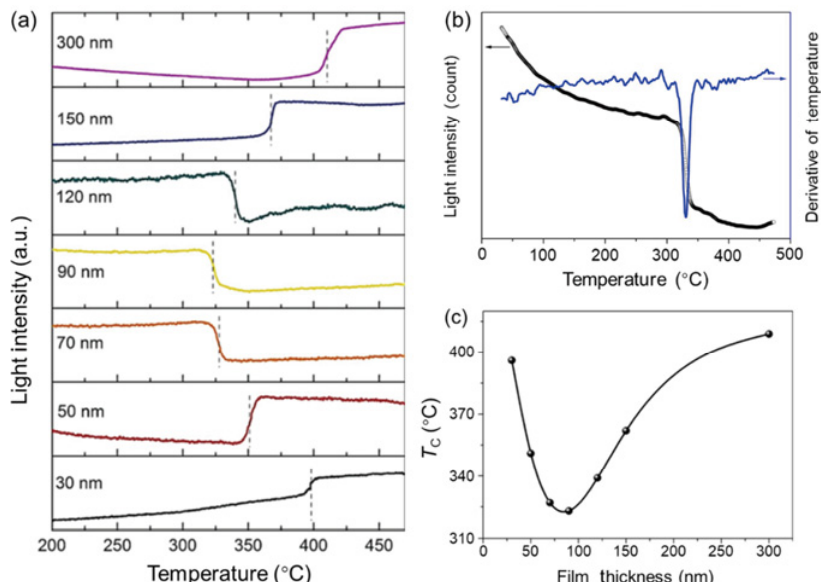
Fig. 1 (a) OPA results of amorphous ZrO 2 films with different thicknesses from 30 to 300 nm, (b) reflected light intensity and its first derivative as a function of temperature for 90-nm-thick sample, and (c) T C extracted from (a) as a function of film